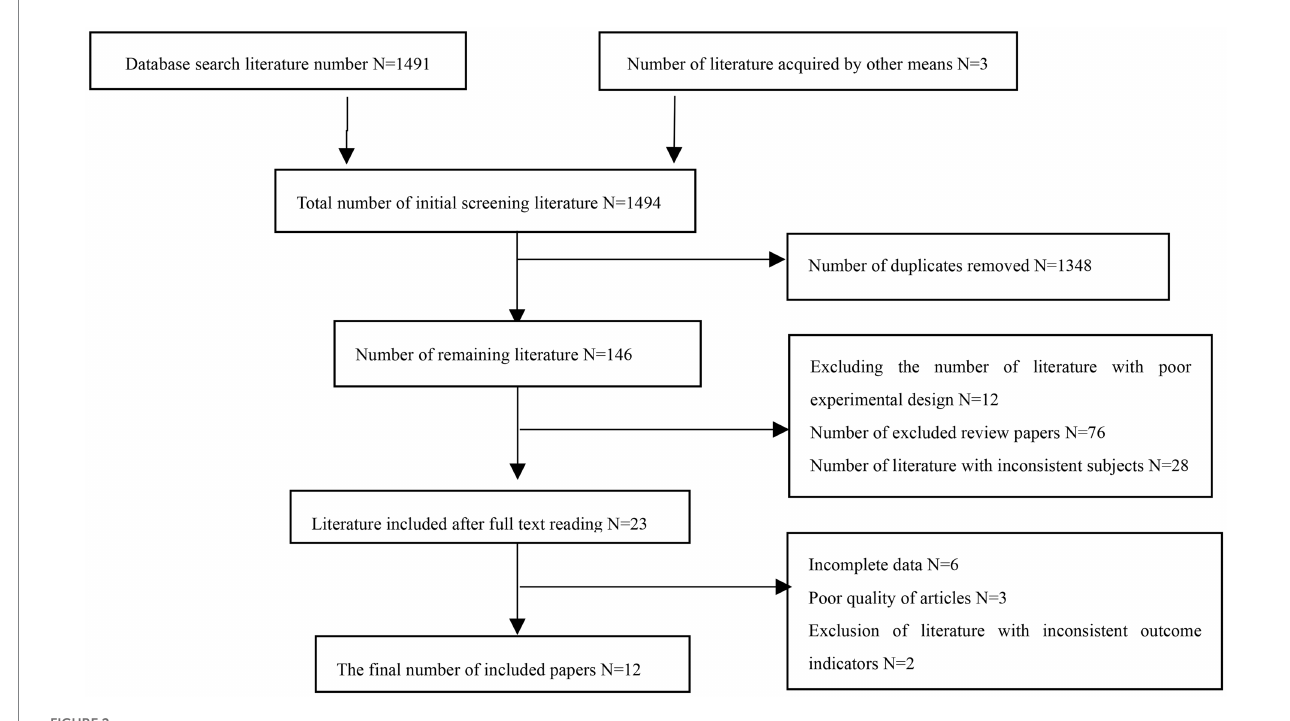
FIGURE 2 Flow diagram of study selection.